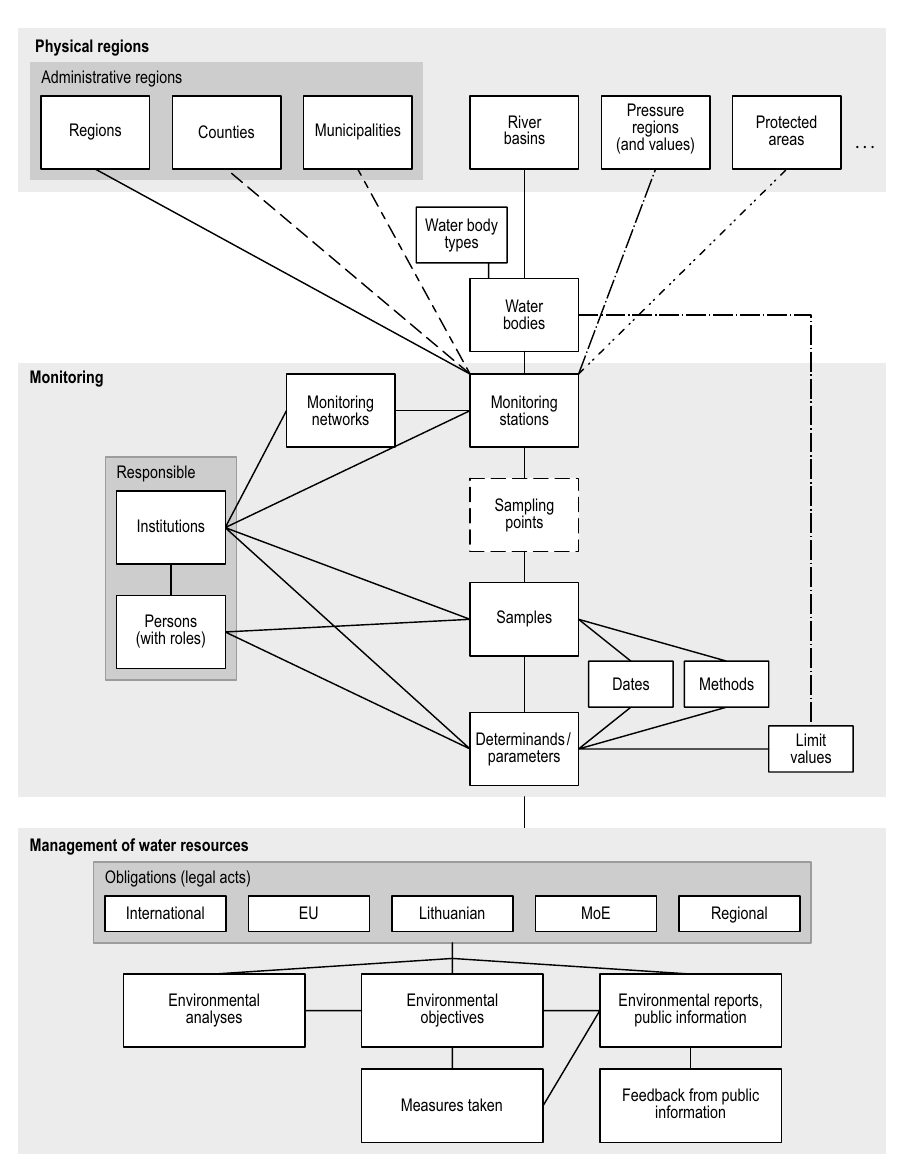
Fig. 1. The scheme of water monitoring and